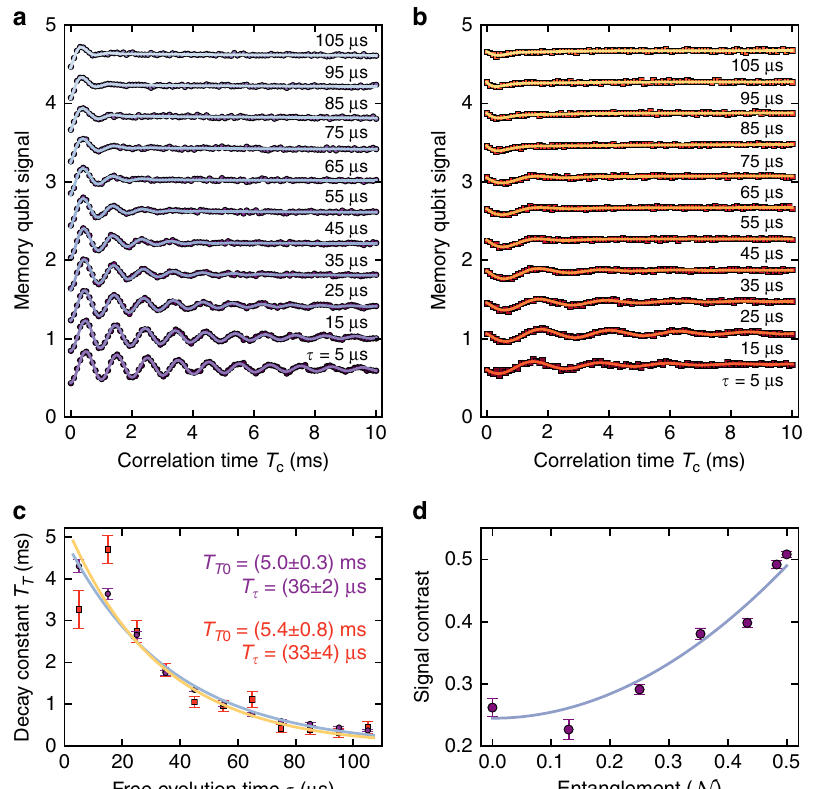
Figure 2 | Comparison of enhanced and conventional correlation measurements. ( a , b ) Stacks of correlation measurements for full (( a ) Z ¼ 1) and no entanglement (( b ) Z ¼ 0) between sensor and memory qubit for various sensing times t as stacking parameter. Associated measurement sequences are given in Fig. 1c. The memory readout signal (that is, the probability of detecting state 1 j i ) is plotted against the correlation time T c (stack-offset n (cid:5) 0.4, n A {0, 1, y 10}). Oscillations on the signal are introduced artificially by a phase offset j ¼ 2 p (cid:5) T c (cid:5) f T , f T ¼ 1kHz ( a ) and f T ¼ 0.5kHz ( b ) to sample the stored quantum phase (see equations 6 and 7). All data sets are fit by y ¼ y 0 þ A 0 = 2